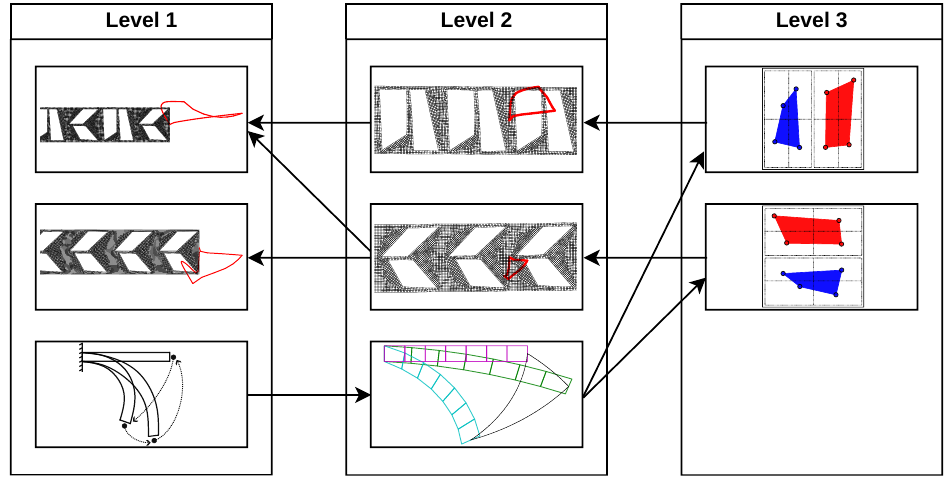
Figure 11. An expanded hierarchical framework with examples of additional HSs in level 2 and level